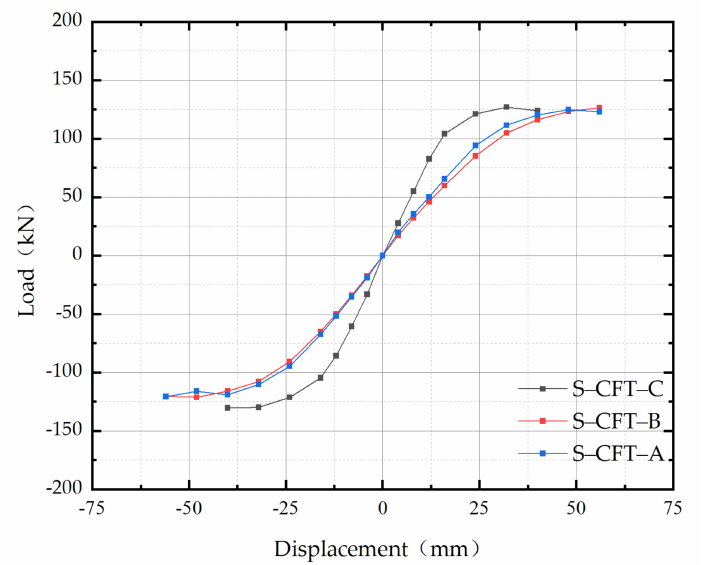
Figure 13. Envelope curves of the